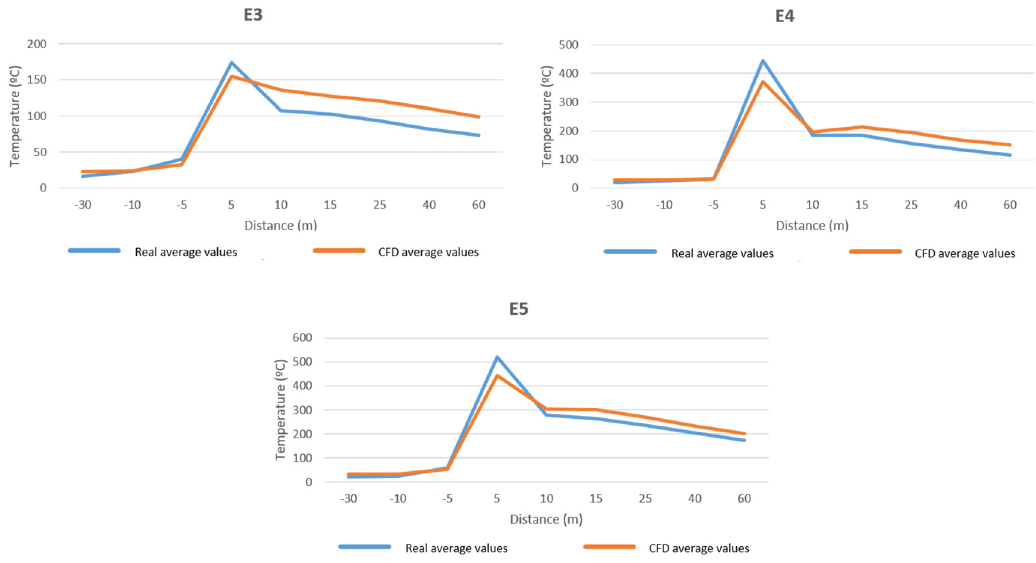
Figure 16. Comparison FDS-Experimental temperature average values along the drift; tests E3–E5.